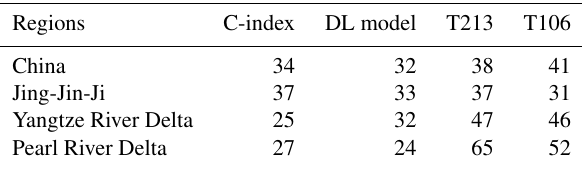
Table 4. Time (in days) for the migration data and NO x emissions to recover to 50% of the pre-CNY level in